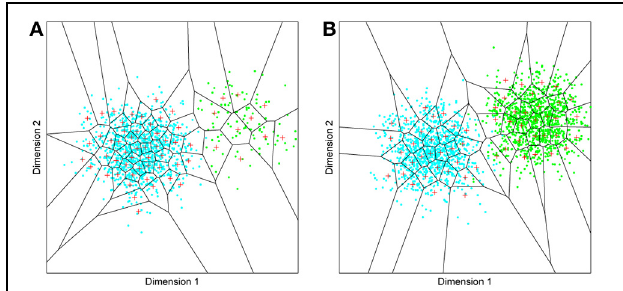
FIGURE 4 | Effects of differing levels of exposure to two subsets of faces. Each “Dimension” could correspond to nameable features such as nose width, hair color, head shape etc., but they might just as well be complex combinations thereof, and hence be hard to characterize in words. The “ + ” points represent the distribution of neural classifiers which emerge from competitive learning of the faces. In other words the “ + ” markers indicate the neural weight vector of the 50 neurons which serve as the set of abstract-feature classifiers. Light blue dots represent the locations of a frequently viewed category of inputs (e.g., own race faces) in the space, and green dots those of inputs viewed less frequently (e.g., other race faces). (A) With 1000 faces from the observer’s own race and 100 from another race, the number of classifiers covering the space occupied by own-race faces is much higher and much more compact (holistic and highly discriminating) than in the other-race region of the input space. (B) Balancing the numbers of exemplars in each race (1000 in each) produces equivalent distributions of classifiers for the two races.